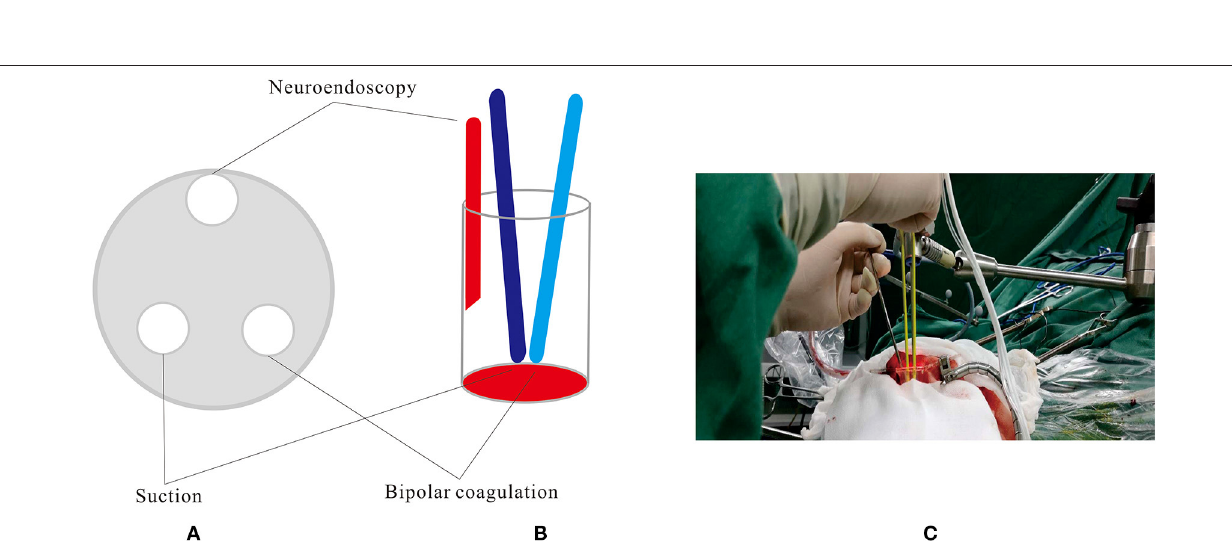
used a paramedian parietal approach ( Figure 1 ). A